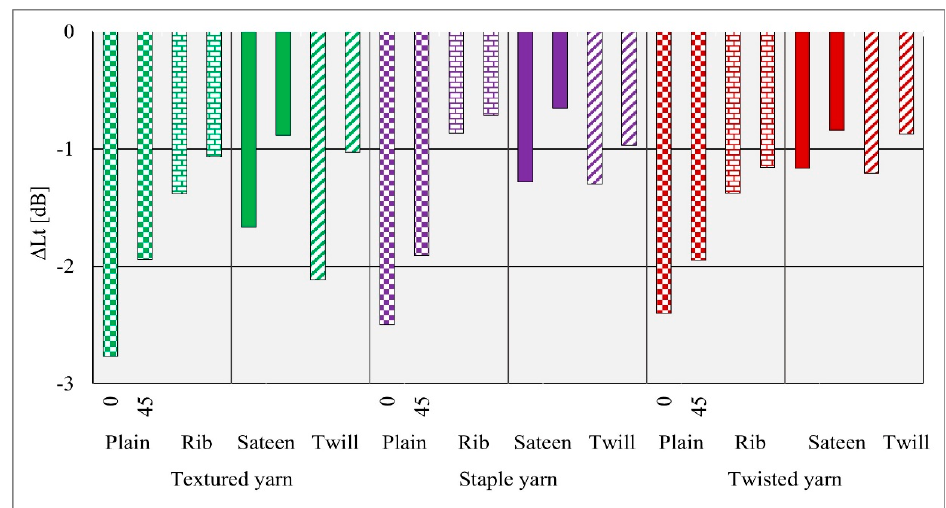
Figure 11. Comparison of sound pressure level drop at the directions of 0° and 45°.